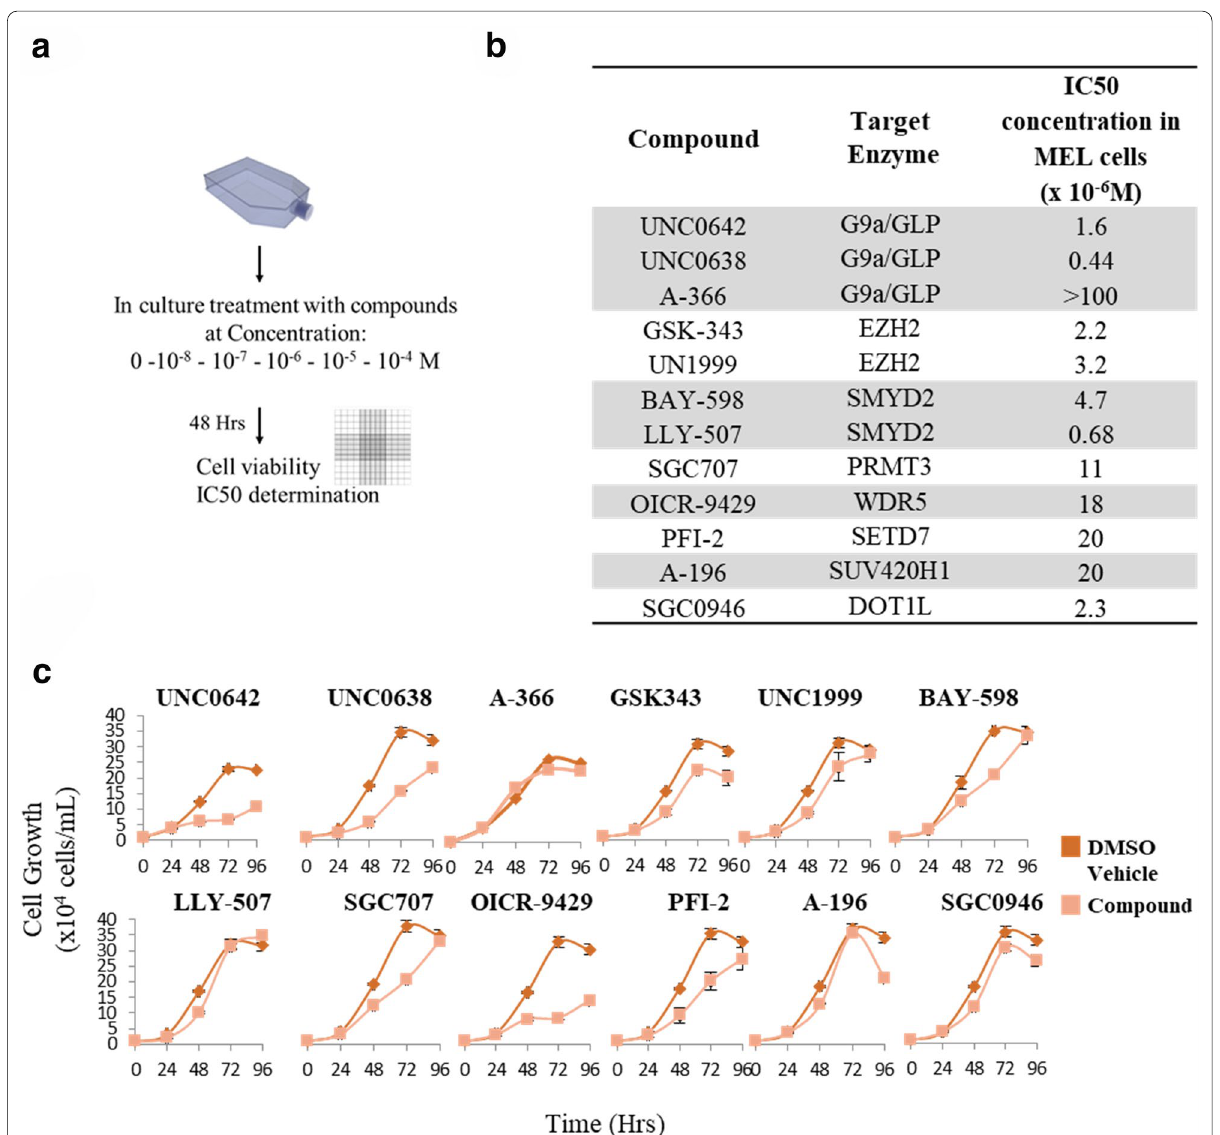
Fig. 2 Assessment of the effects of the epigenetic probes on MEL cell proliferation in culture. a Depiction of the protocol followed for the determination of the IC 50 concentration of the probes. b Table showing each compound’s target as well as the identified IC 50 concentration. c Time-dependent kinetic analysis of the effect of the 12 compounds on the ability of MEL cells to proliferate in culture. Cells were treated continuously with each of the compounds shown in the individual diagrams at their corresponding IC 50 concentration for each probe, and the total cell number was determined daily by cell counting via a Neubauer chamber. All but A-366 compounds showed a mild to severe inhibition of